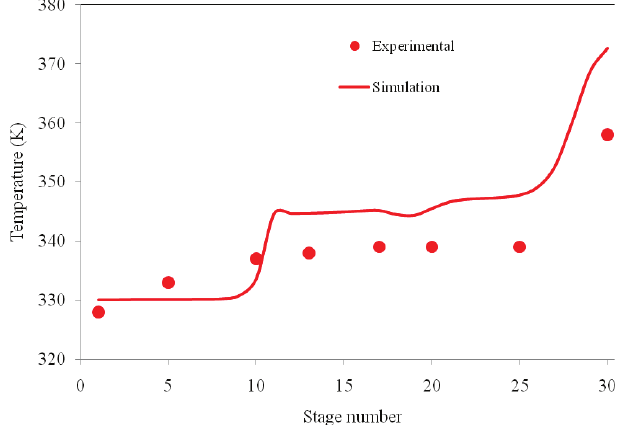
Fig. 6 Temperature profile versus stage number. Solid line represents the simulation results from equilibrium stage model, and Fig. 6 – Temperature profile versus stage number. Solid line symbols represent the experimental data 18 . represents the simulation results from equilibrium stage model, and symbols represent the experimental data 19 . In the reactive distillation process, the reflux ratio has more effect on the conversion of acetic acid. Fig. 7 shows the effect of reflux ratio on the conversion of acetic acid. The acetic acid conversion reached maximum at a reflux ratio of about 2, and after that it gradually decreased when the reflux ratio increased. From Fig. 7, it could be observed that the experimental and model predictions are in good agreement, so equilibrium stage wise model was justified for the simulation of the reactive distillation process for the present esterification system.